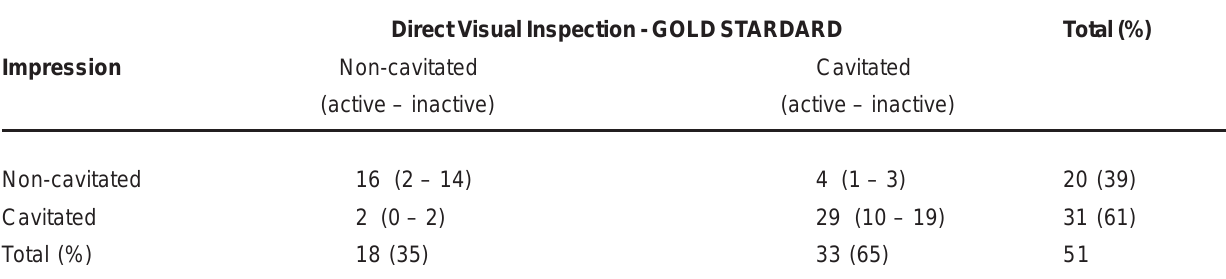
TABLE 2- Distribution of cavitated and non-cavitated lesions on impression and visual inspection examination (gold- standard)